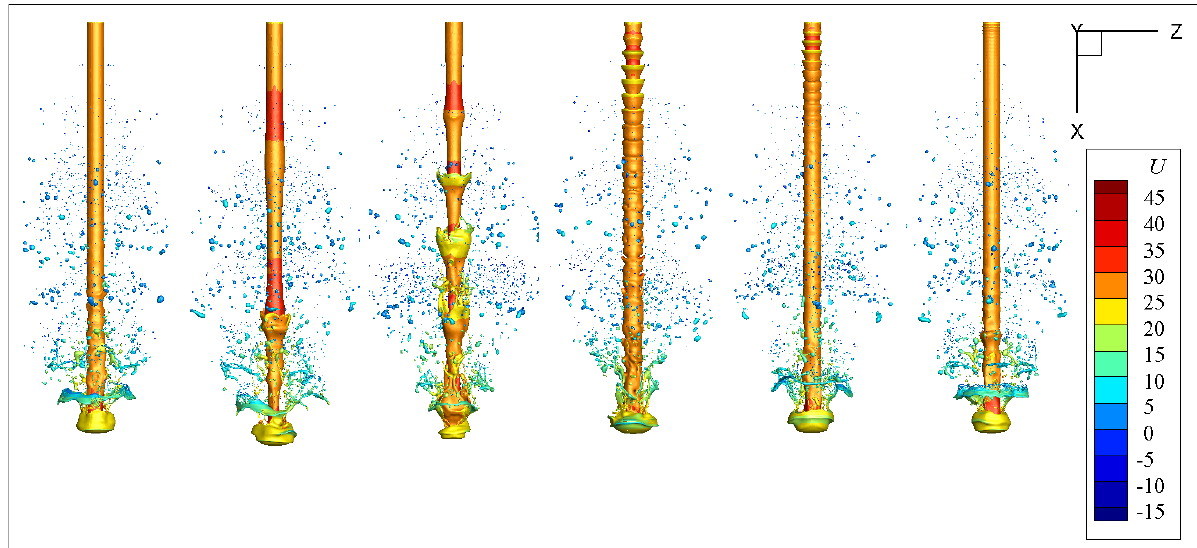
Figure 8. The overall flow structure at different disturbance frequencies (from left to right f = 0, 30, 66.6, 300, 450, and 1500 kHz). The color indicates the axial velocity in m/s.